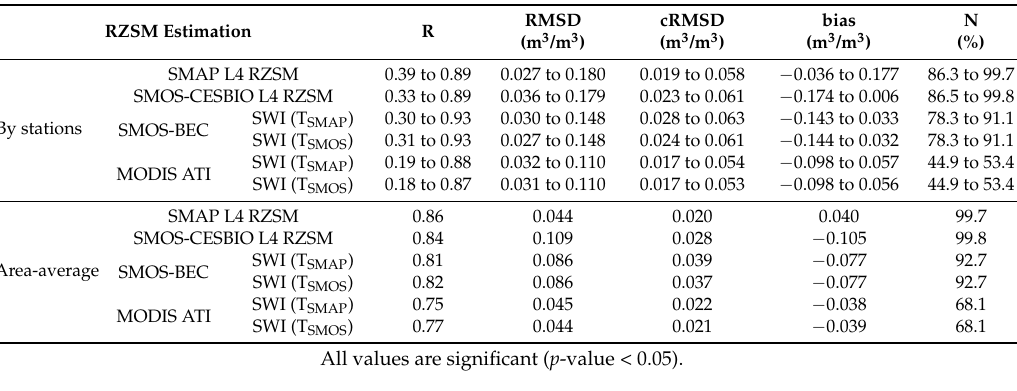
Table 2. Statistics obtained from comparison of the six RZSM estimates (by stations and area-average) with the in situ RZSM across REMEDHUS. N indicates the number of coincident data days.